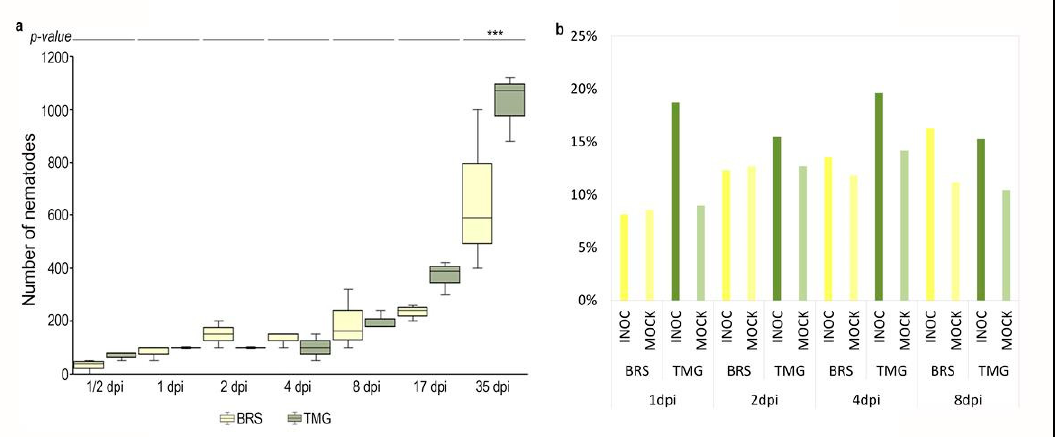
Figure 5. Nematode reads in RNA-seq data and infection progress. Boxplot of nematode counting from BRS and TMG roots during the course of RLN infection ( a ). *** Significant difference between BRS and TMG with p-value < 1%. Percentage of mapped reads against Pratylenchus penetrans transcriptome (mapped reads in mock samples is due to rRNA genes) ( b ).